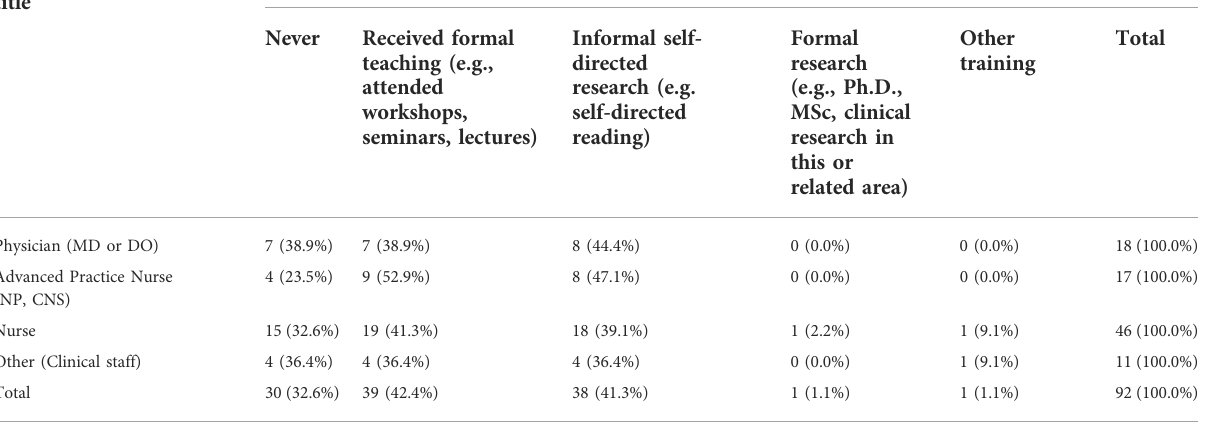
TABLE 3 Delirium prevention education/training reported by healthcare providers categorized by type of healthcare provider. Healthcare provider